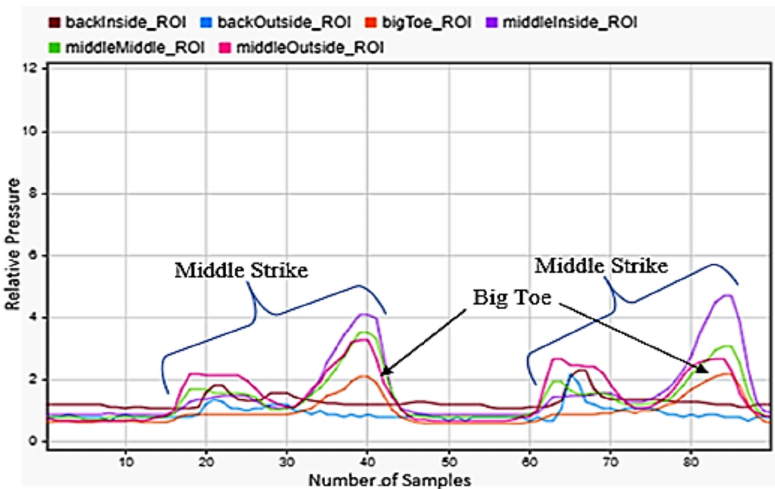
Figure 7. Stair descent sensor readings for left foot.